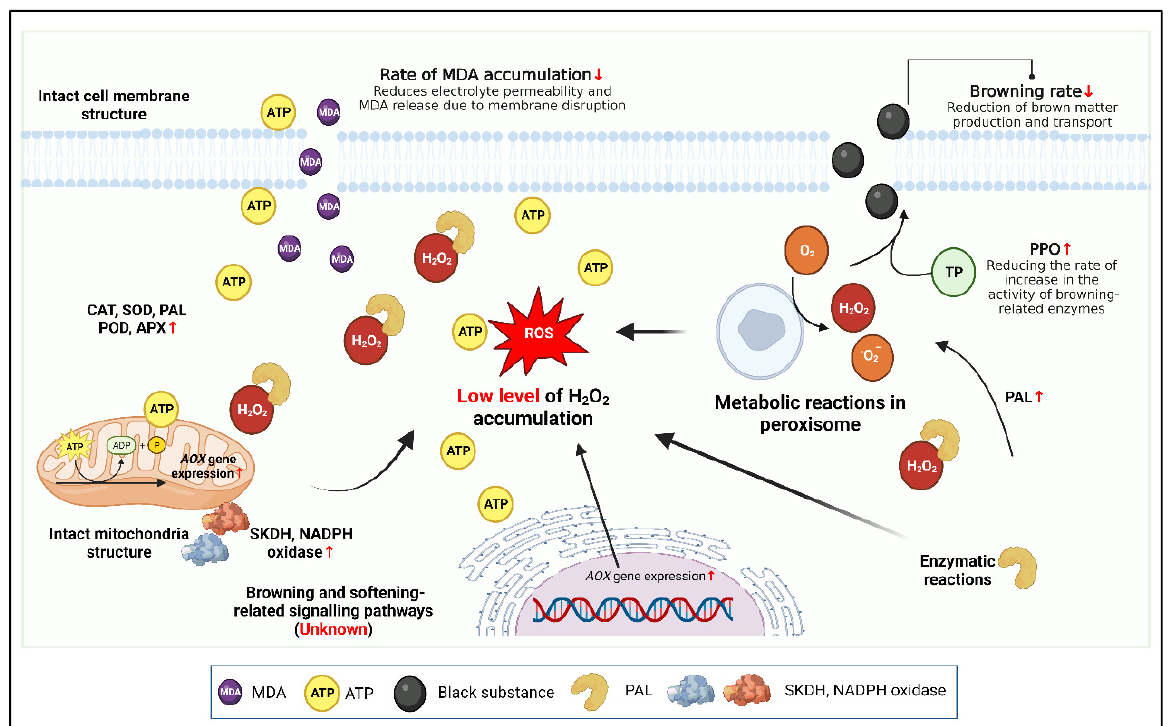
Figure 5. Application and mechanism of action of melatonin in the preservation of edible mushrooms. Created with BioRender.com.